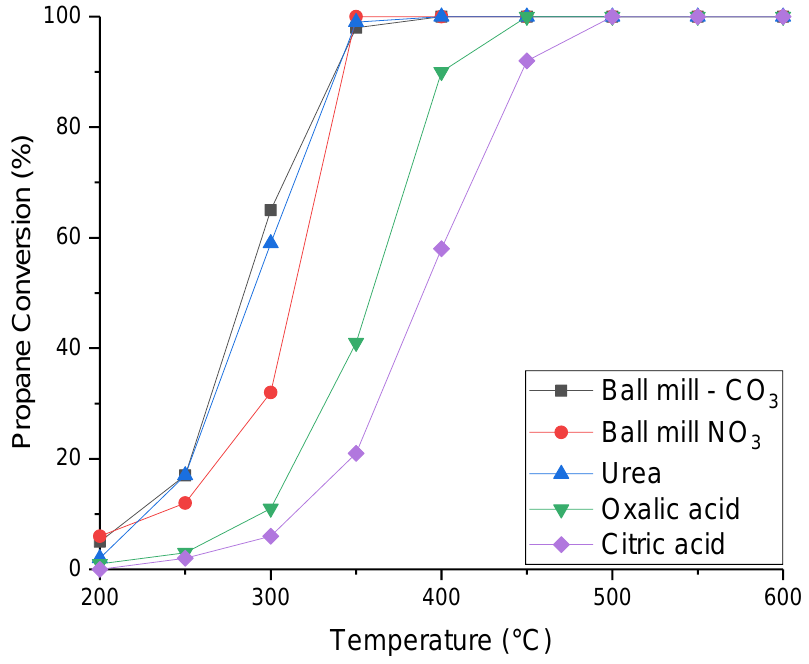
Figure 7. Propane conversion as a function of temperature of Ce 0.25 Mn 0.75 O x catalysts synthesised by different methods. Reaction conditions: 5000 ppm propane in air, Gas hourly space velocity (GHSV) = 45,000 h − 1 , Temperature = 200 –600 °C.